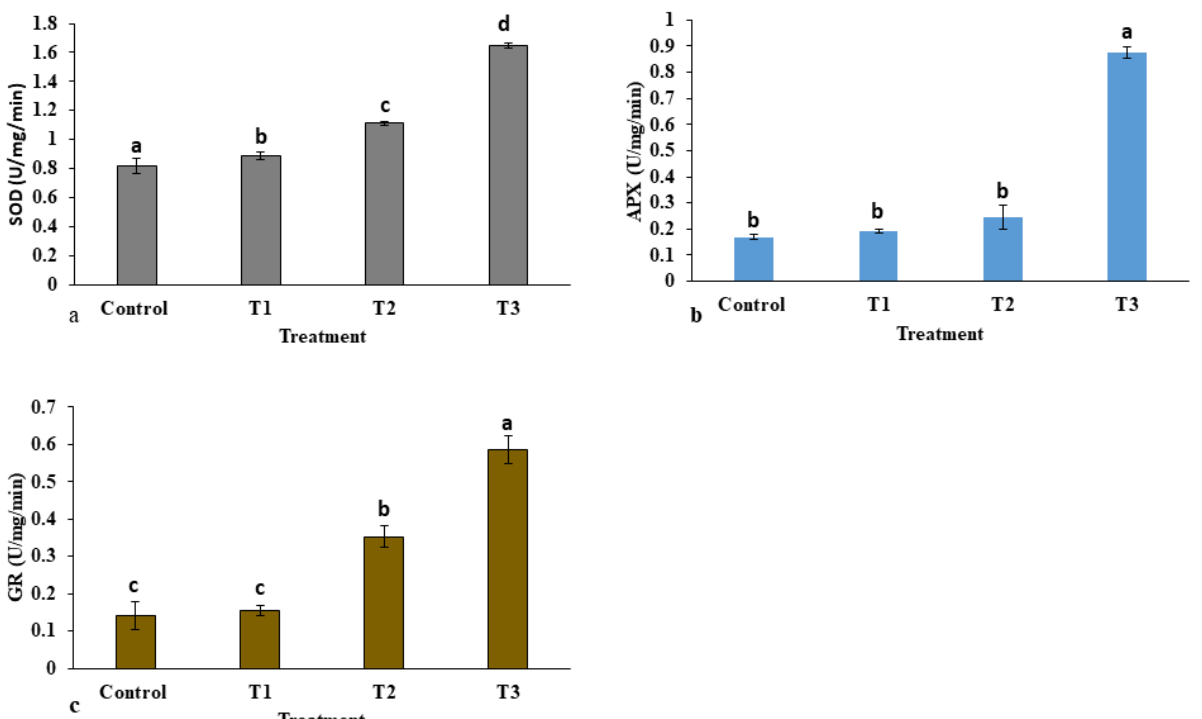
Figure 8. Effect of ZnO-NPs on antioxidant enzyme activities in E. macrochaetus : ( a ) superoxide dis- mutase (SOD); ( b ) ascorbate peroxidase (APX); ( c ) glutathione reductase (GR). Treatments including control (0 mg/L, ZnO-NPs); T1 (10 mg/L, ZnO-NPs); T2 (20 mg/L, ZnO-NPs) and T3 (40 mg/L, ZnO-NPs). Bars represented by different letters indicate significant values according to Duncan’s test ( p <